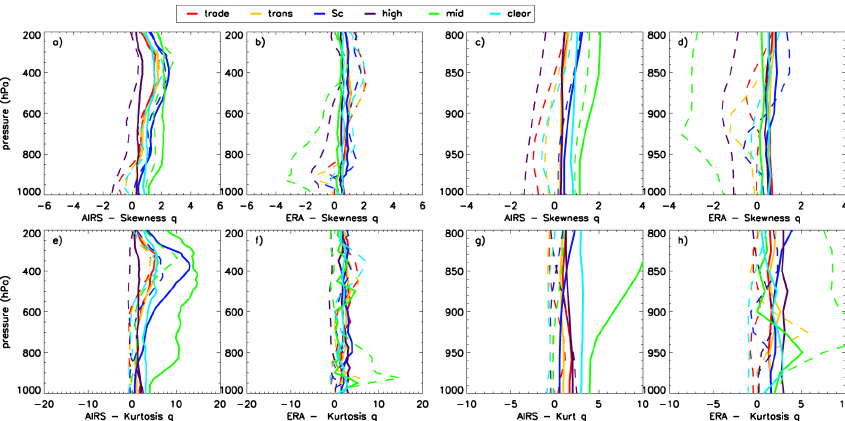
Fig. 8. The same as Fig. 6 except for the vertical profile of water vapor mixing ratio